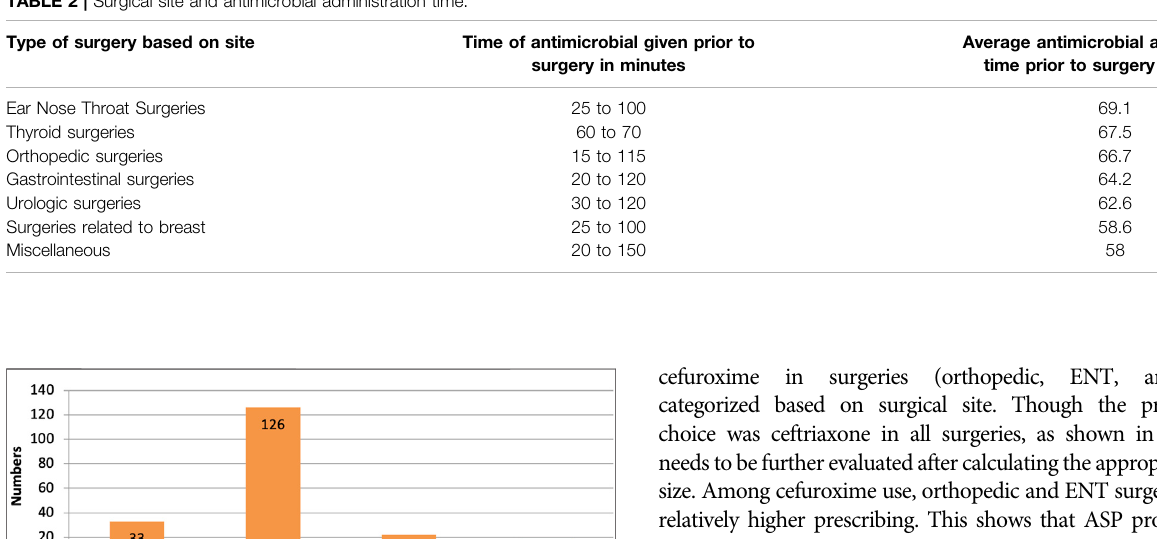
TABLE 2 | Surgical site and antimicrobial administration time.